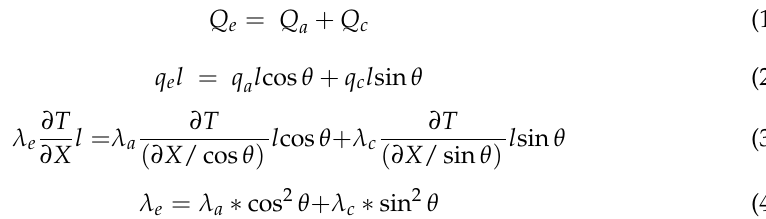
Figure 1. Establishment of a series of unit cell models by shape interpolation. ( a ) Two-dimensional